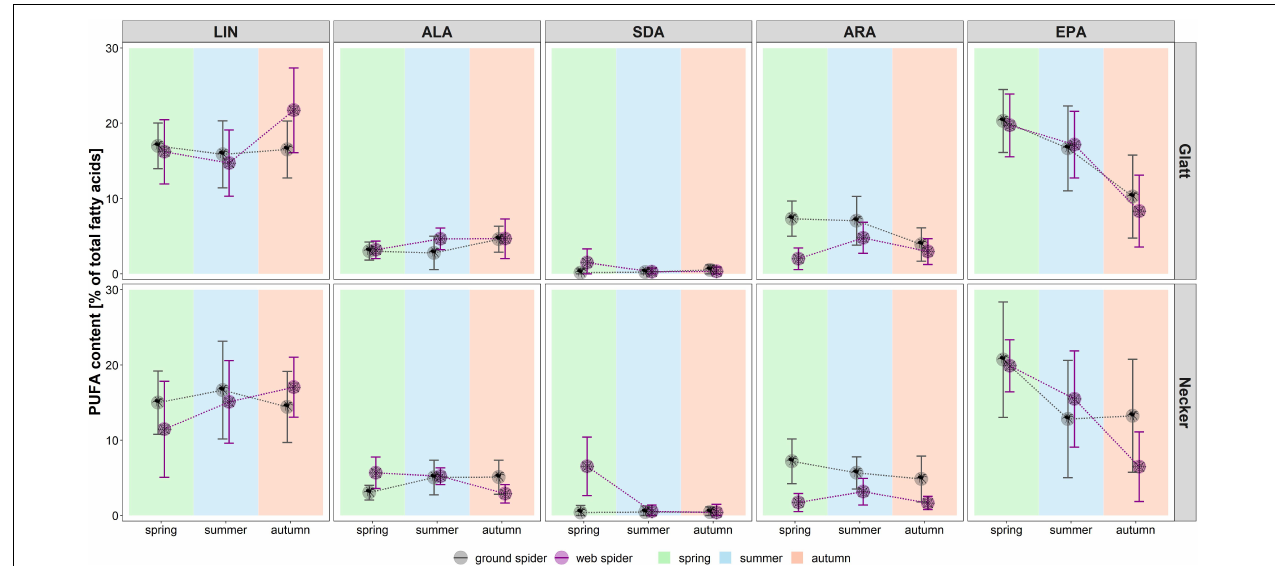
FIGURE 2 | Individual PUFA content (as % of total fatty acids) in web spiders ( n = 69) and ground spiders ( n = 71) separated by stream and season. Points represent mean content, and error bars represent standard deviation, background colors represent the three seasons (spring, summer, and